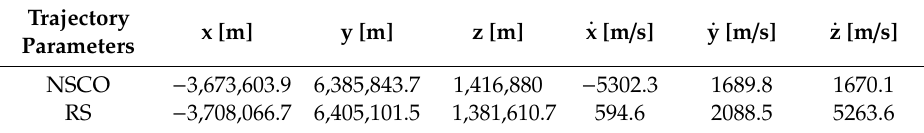
Table 1. The initial trajectory parameters of reference spacecraft (RS) and non-cooperative space object (NCSO) in epoch Earth-centered inertial (EECI) coordinate system.